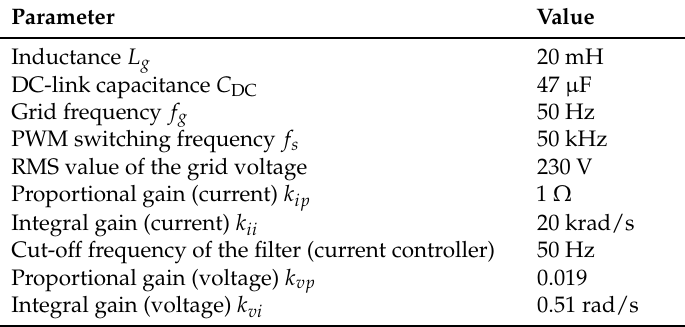
Table 2. The parameters used for the DC-AC inverter.